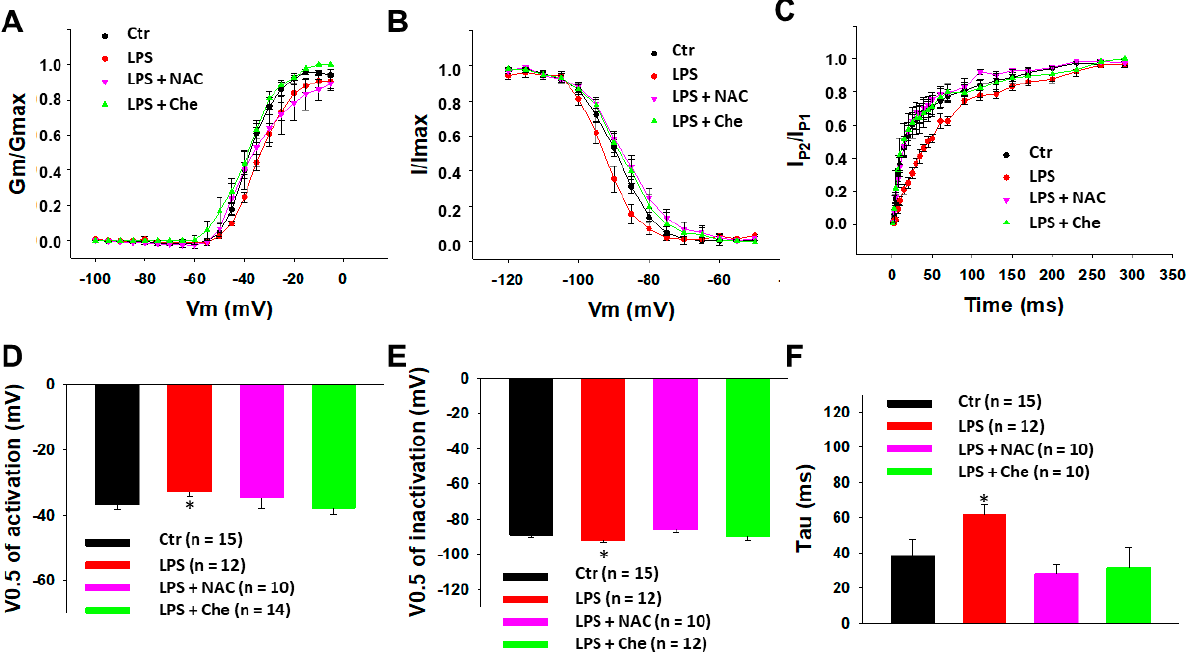
Figure 6. A ROS and PKC blocker prevented the LPS effects on sodium channel gating kinetics in SCN10A-hiPSC-CMs. Cells were treated for 48 h with vehicle (Ctr) or LPS of 2 μ g/mL (LPS) or LPS plus 1 mM N -acetylcysteine (LPS + NAC) or LPS plus 5 μ M chelerythrine (LPS + Che). ( A ) Activation curves of peak sodium channel currents (I Na ) recorded in SCN10A-hiPSC-CMs. ( B ) Inactivation curves of peak I Na recorded in SCN10A-hiPSC-CMs. ( C ) Recovery curves of peak I Na recorded in SCN10A-hiPSC-CMs. ( D ) Mean values of V0.5 of activation. ( E ) Mean values of V0.5 of inactivation. ( F ) Mean values of time constants (Tau) of recovery from inactivation. Numbers given in ( D – F ) represent the number of cells of measurements also for ( A – C ). * p < 0.05 versus Ctr according to one-way ANOVA with Holm–Sidak post-test.